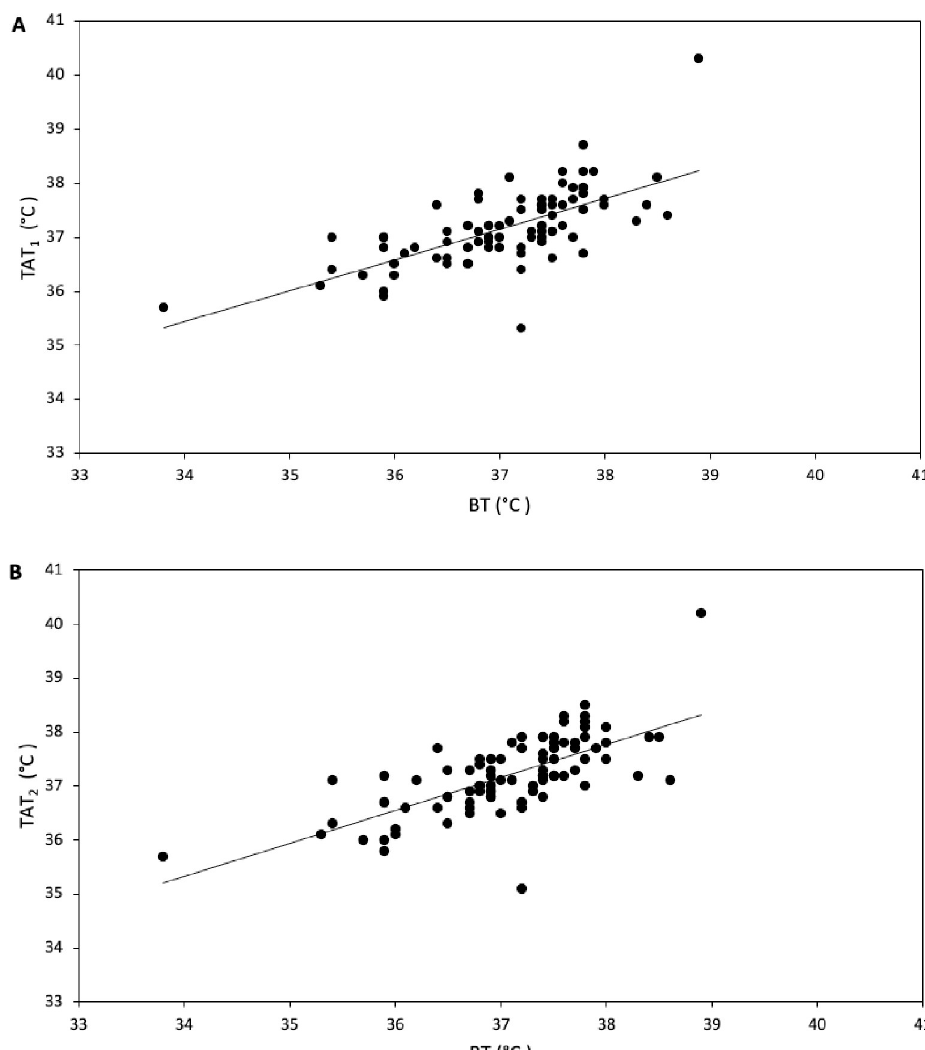
Fig 2. Scatter plots. A. Scatter plot for measuring body temperature. Correlation between body temperature data obtained with the temporal artery thermometer by observer 1 (TAT 1 ) and bladder thermometer (BT) is illustrated. B. Scatter plot for measuring body temperature. Correlation between body core temperature data obtained with the temporal artery thermometer by observer 2 (TAT 2 ) and bladder thermometer (BT) is illustrated.